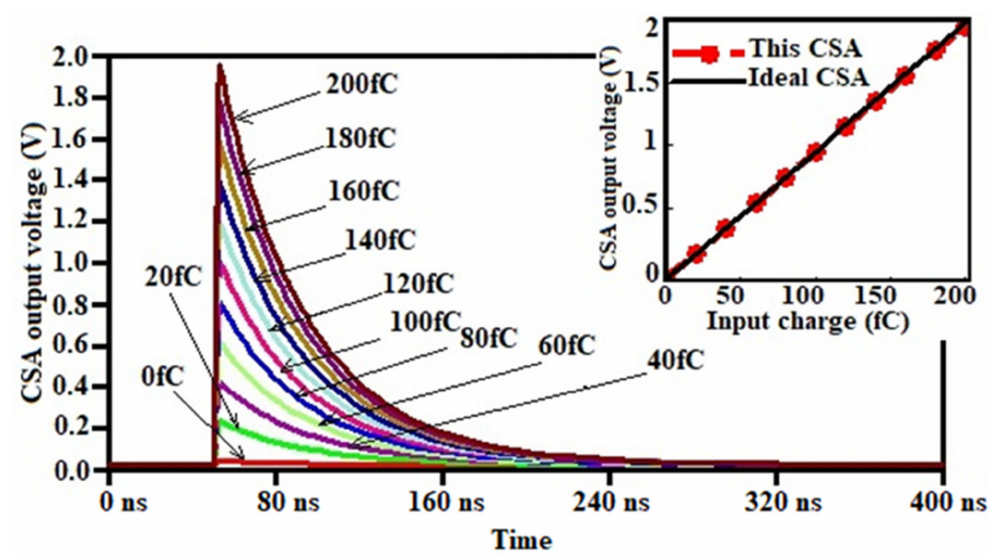
Figure 14. CSA output voltage for different input charge.